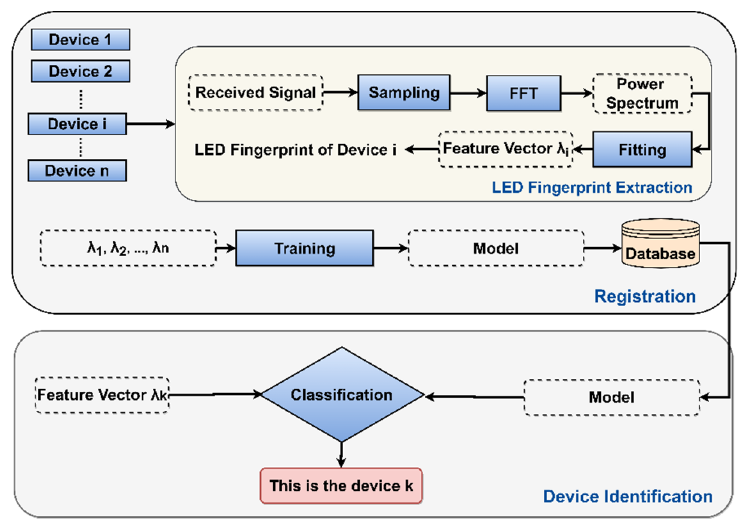
Figure 2. LED Fingerprint Extraction and Identification Mechanism.